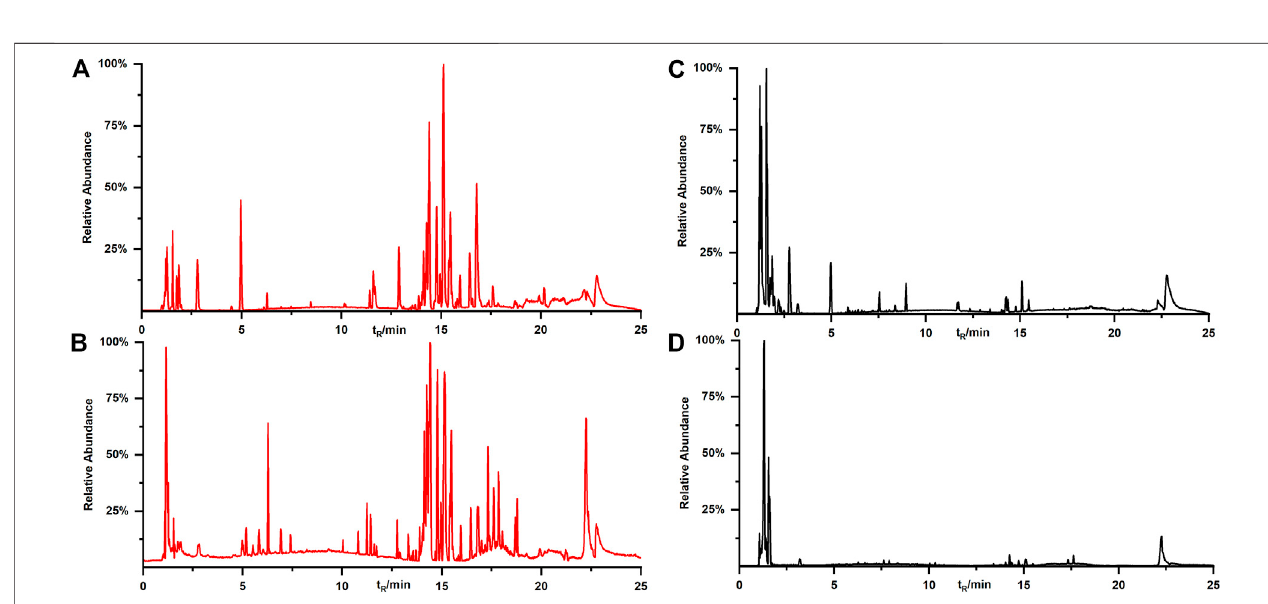
Frontiers in Pharmacology |